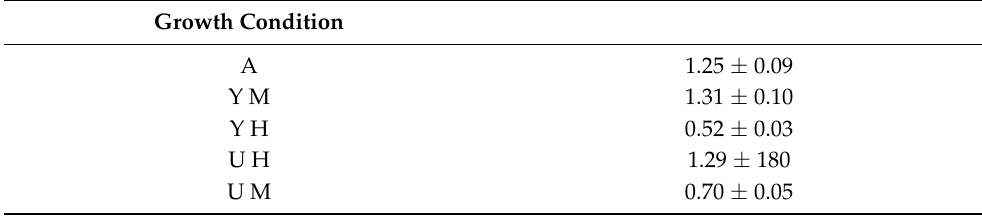
Table 1. Accumulated biomass of the Chlorella strain after 8 days of growth under conditions of cultiva- tion: autotrophic (A), mixotrophic with glycerol (Y M), heterotrophic with glycerol (Y H), mixotrophic with glucose (U M), heterotrophic with glucose (U H). Means ± standard deviations, n = 8. Growth Condition